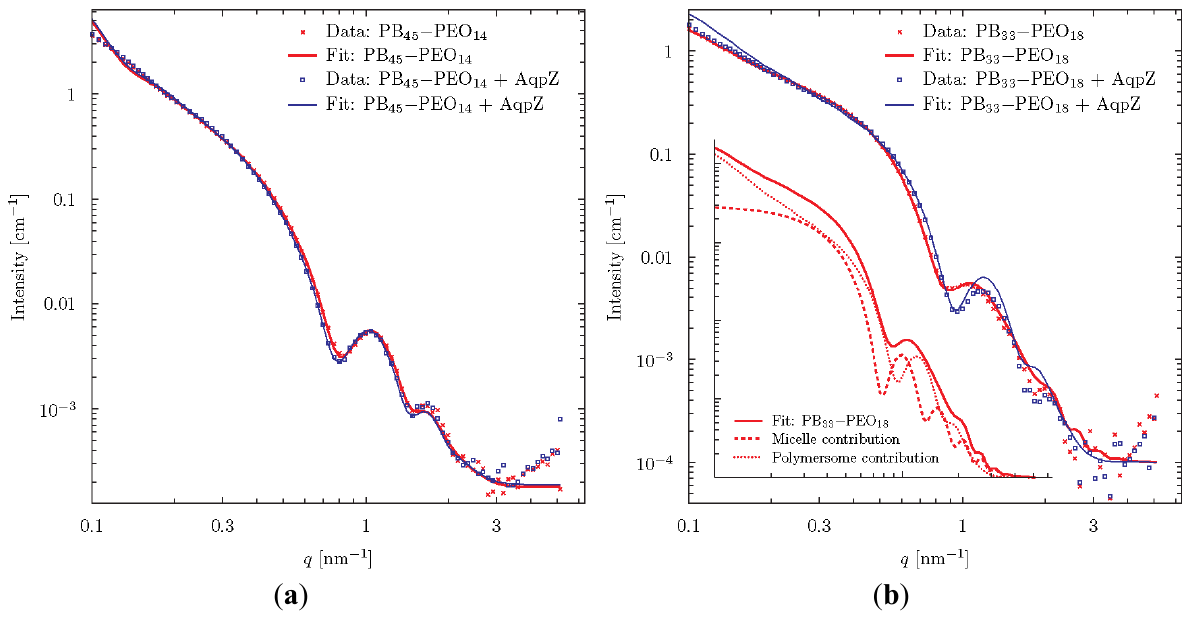
Figure 7. SAXS data for proteo- and polymersomes of PB 45 -PEO 14 ( a ) and PB 33 -PEO The fits were obtained using a vesicle model consisting of three concentric spherical